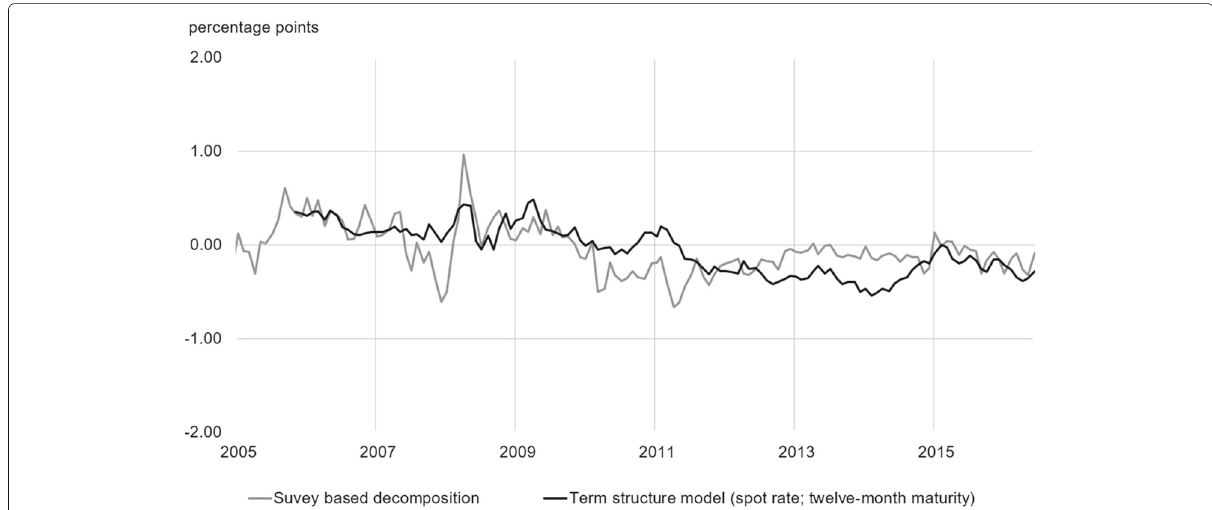
Fig. 8 Comparison of approaches. The figure compares the model-free estimation of the CHF term premium with the term premium obtained from an Arbitrage-Free Nelson-Siegel term structure model by Christensen and Krogstrup (2018)